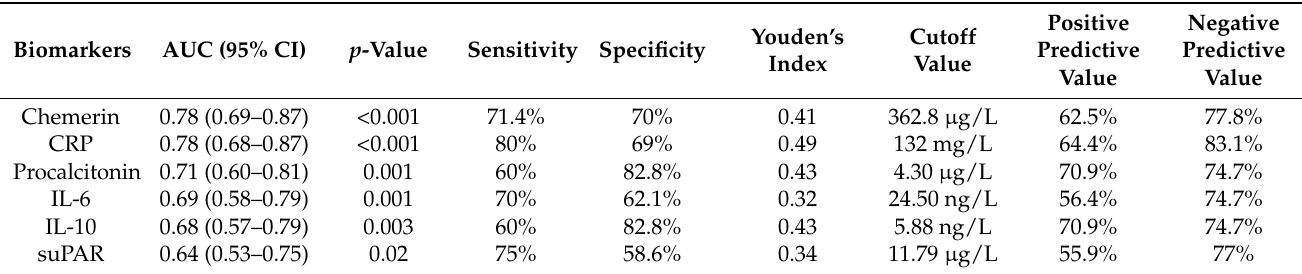
Table 3. Receiver operator characteristic curve analysis to ascertain the optimum cutoff value of major circulating biomarkers at enrollment in order to discern sepsis from septic shock in 102 patients with